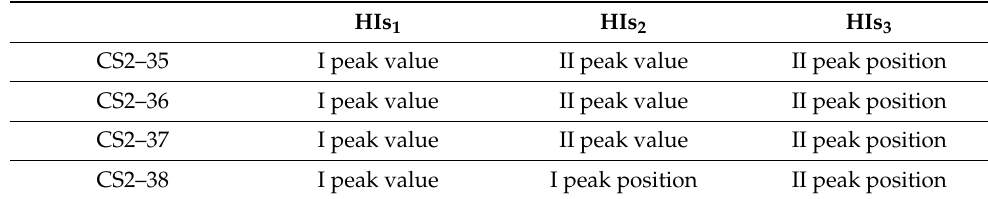
Table 3. Collection of selected